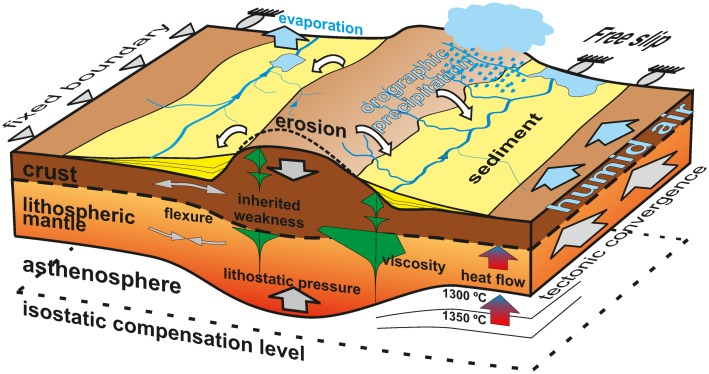
Conceptual cartoon with the processes integrated in the model.Not to scale. River erosion and sediment transport is calculated using a stream power approach and allowing the water follow the maximum slope. Evaporation is explicitly accounted for in lakes. The horizontal tectonic velocity is predefined at the boundaries. The viscosity of the lithospheric layer is dependent on the thermal regime and lithological parameters. The thickness of crustal and mantle varies according to the accommodation of the boundary velocities, depending on the viscosity distribution.